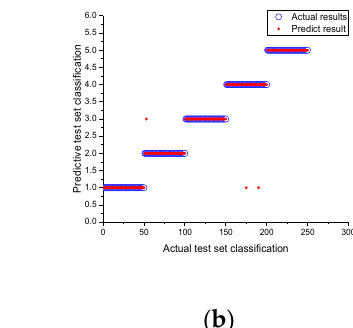
Table 4. Comparison of PNN/SVM classification results. Classification Model